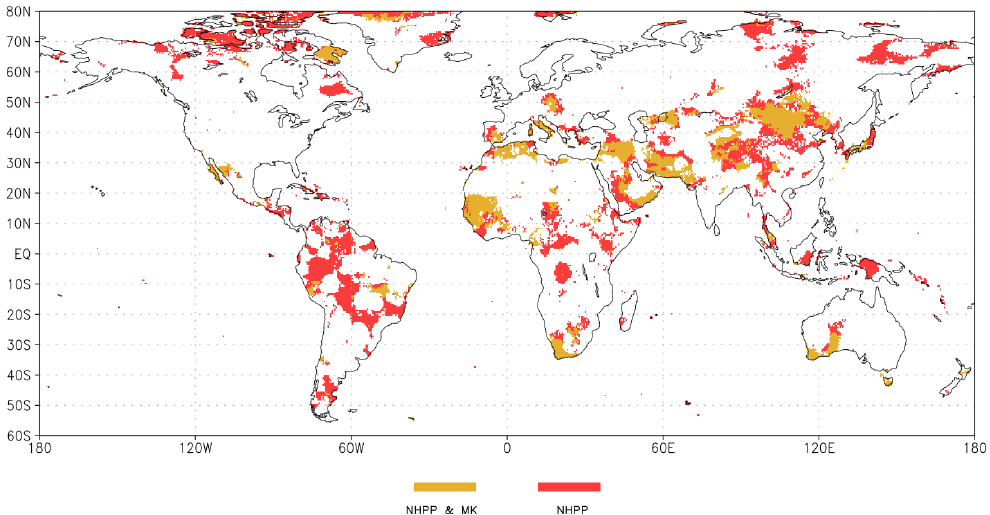
Figure 6. Areas of the globe interested by an increasing trend of drought episodes identified by SPEI-6 for the month of March. Significant positive trend: (1) only for NHPP (red areas); and (2) for NHPP and M-K (yellow